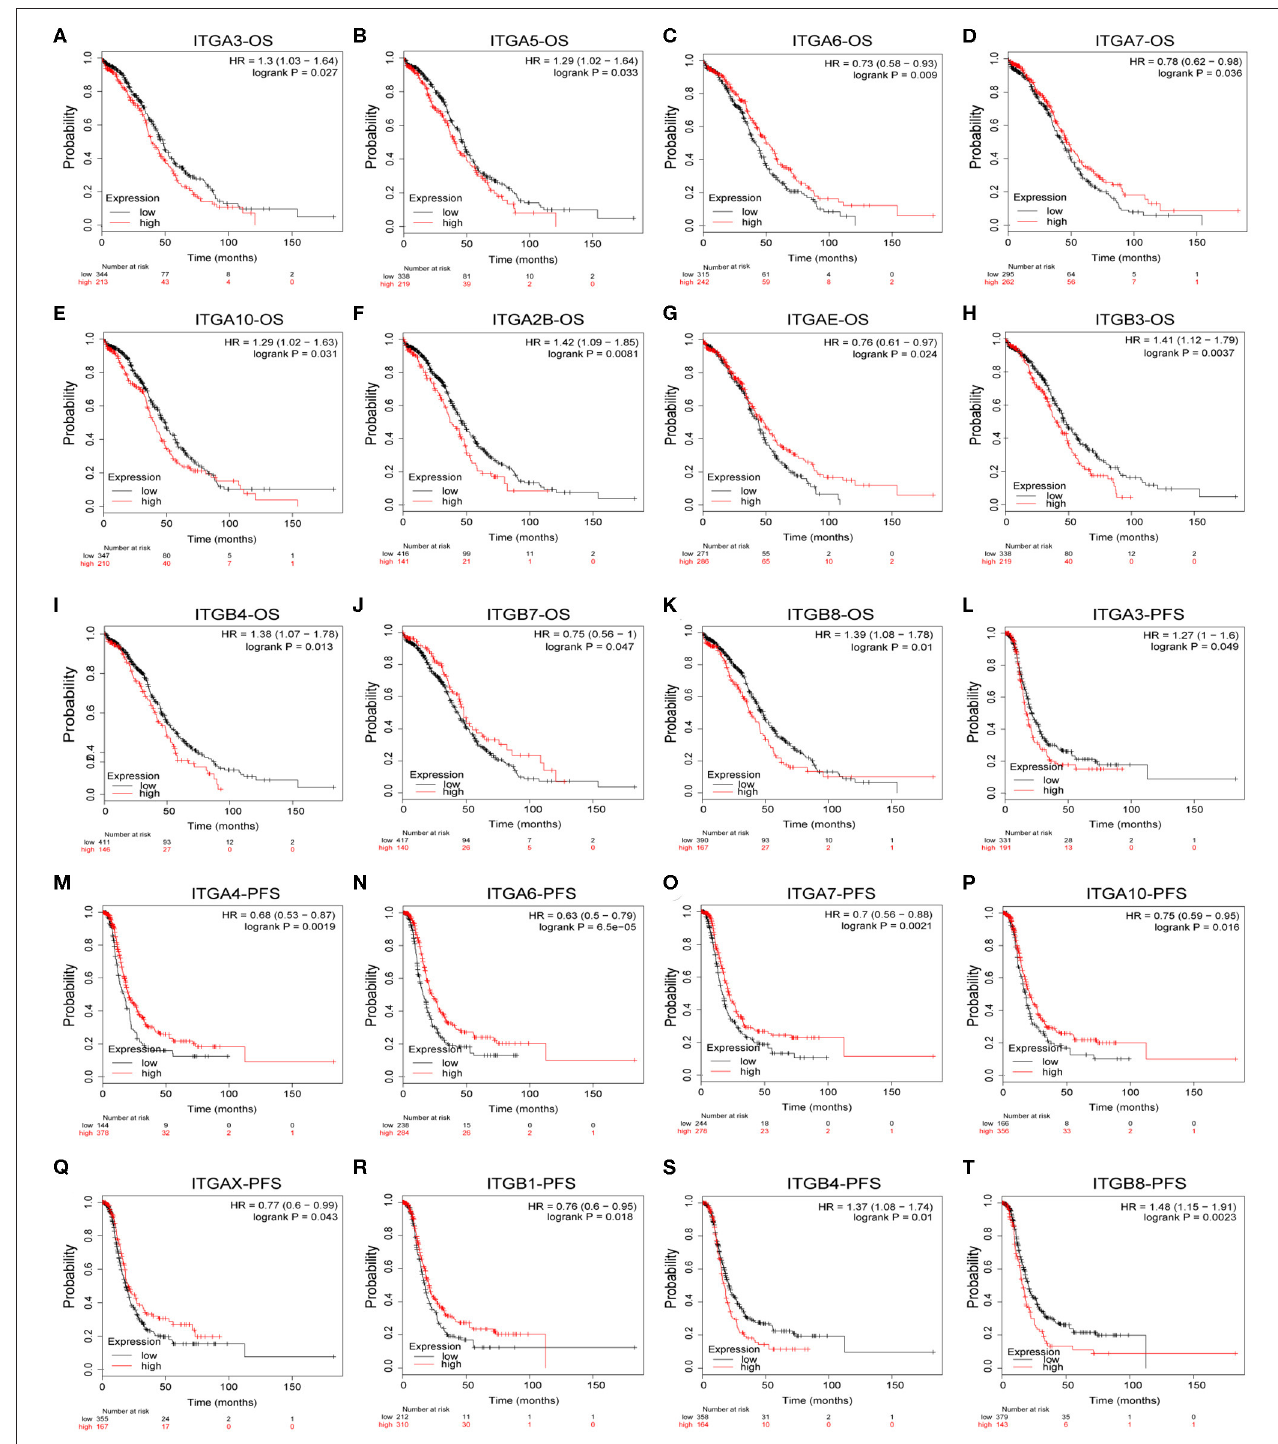
FIGURE 3 | Prognostic value of integrin genes mRNA in OC. (A–K) Integrin genes showed significant correlations with OS in OC. (L–T) Integrin genes showed significant correlations with PFS in OC.